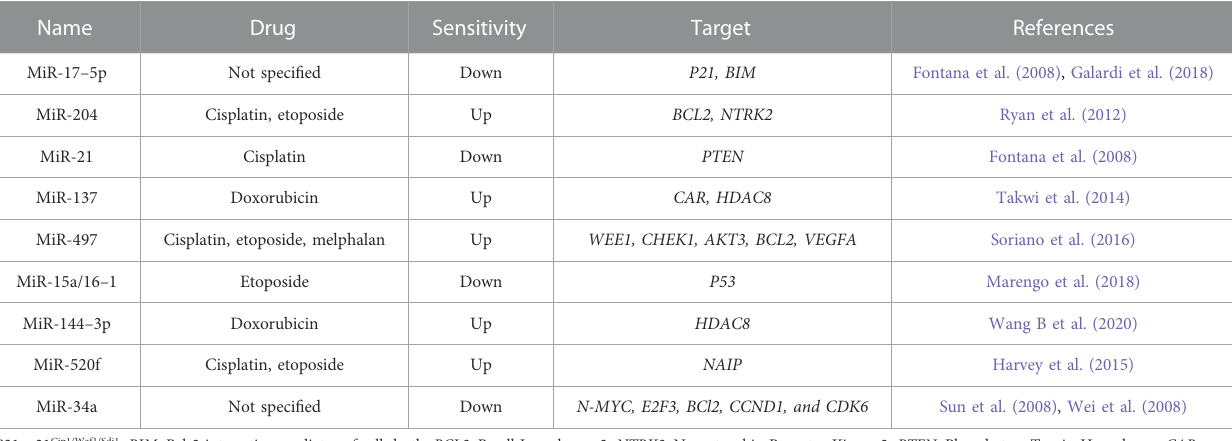
TABLE 1 miRNAs involved in drug resistance in